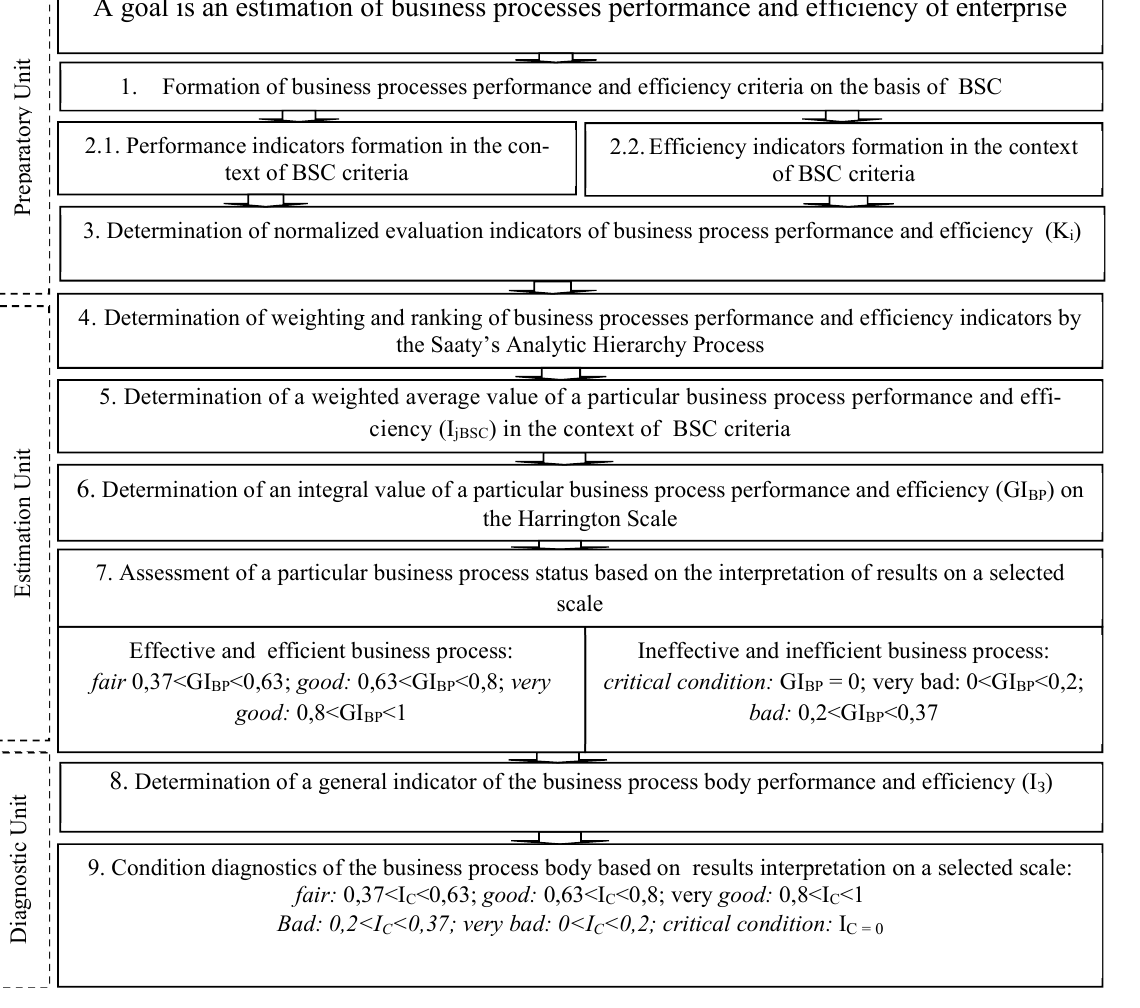
Fig. 1. Methodological approach in an enterprise’s business processes estimation Source: proposed by the